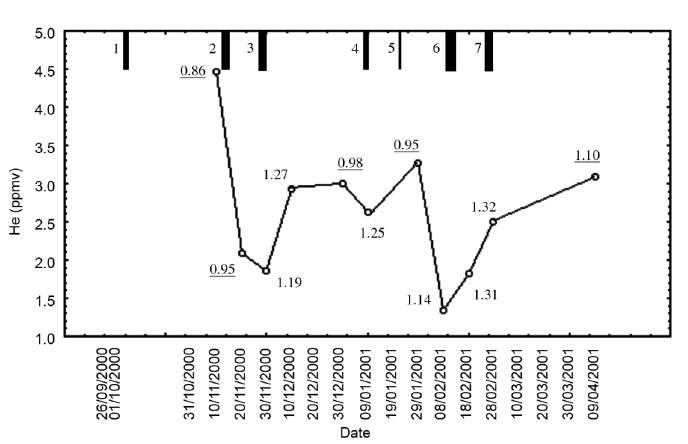
Fig. 4. Helium variation. 3 He/ 4 He ratio ( × 10 − 6 ) is reported for each data point. Underlined ratios are those of the bottom-water group identified in fig.